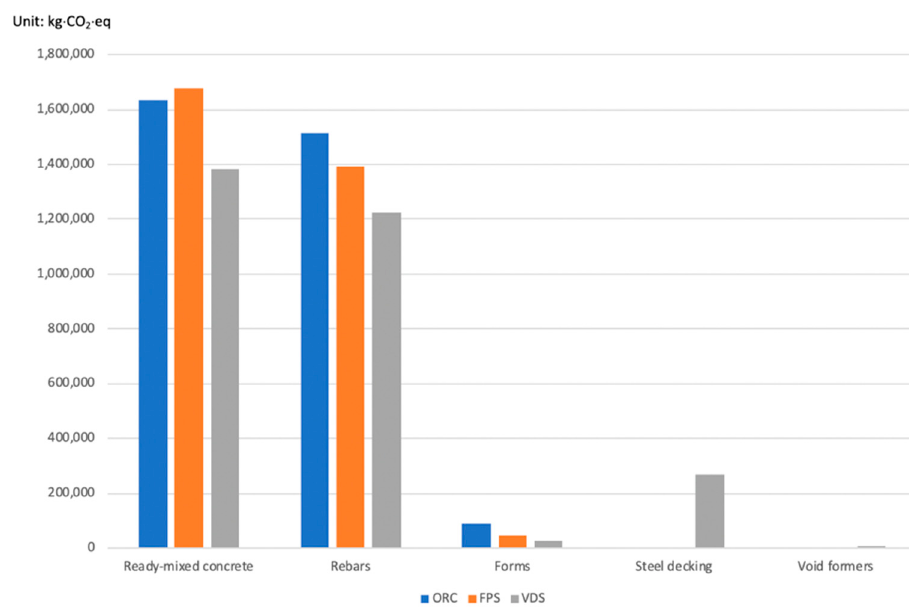
Figure 6. Carbon dioxide emissions of building materials.